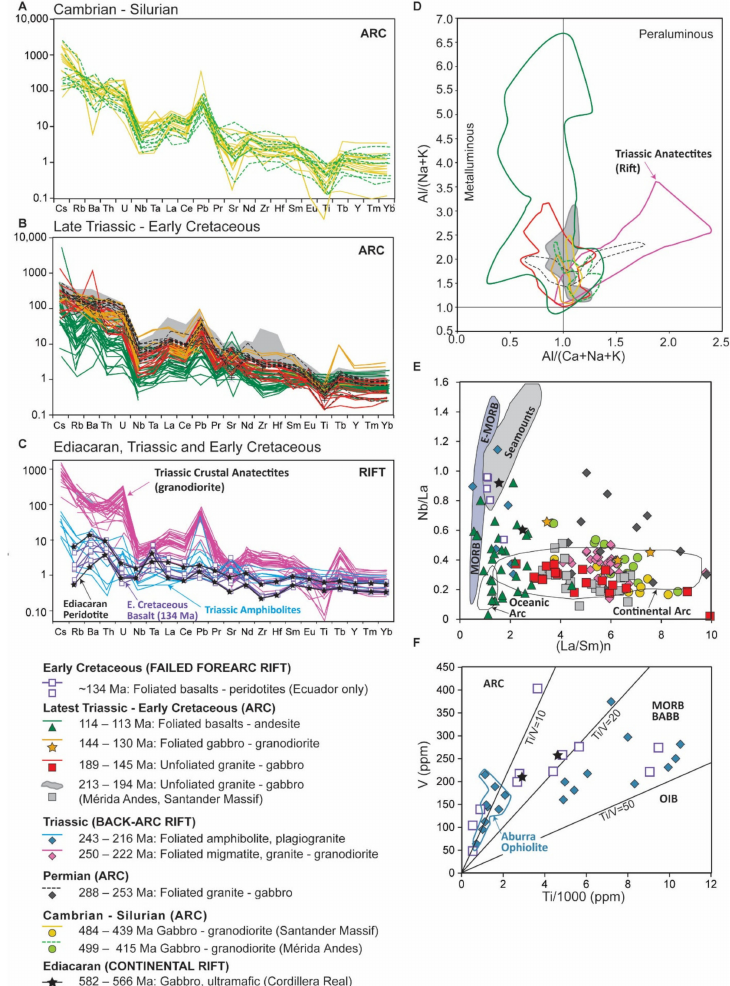
Figure 5. Summary whole rock geochemical data from igneous rocks that crystallised during 499–112 Ma in Venezuela, Colombia and Ecuador. ( A ) Cambrian–Earliest Devonian continental arc intrusions that are exposed in the M é rida Andes and the Santander Massif. ( B ) Permian–Early Cretaceous continental arc intrusions that are mainly exposed in the Sierra Nevada de Santa Marta and the cordilleras Central and Real, showing a gradual depletion towards younger rocks. ( C ) Late Neoproterozoic, Triassic (felsic and mafic end members) and Early Cretaceous rift. ( D ) discrimination between peraluminous and metaluminous rocks using Al, Ca, Na and K [67] showing the highly per- aluminous nature of the Triassic, rift-related crustal anatectites. ( E ) Discrimination between depleted mantle (MORB, E-MORB) and arc settings for all of the dated units (499–112 Ma) using (La/Sm)n v Nb/La [68]. ( F ) Discrimination between arc and extensional settings using Ti and V [69]. Data are from Litherland et al. (1994) [17], Nivia et al. (2006) [63], Martinez et a. (2007) [38],